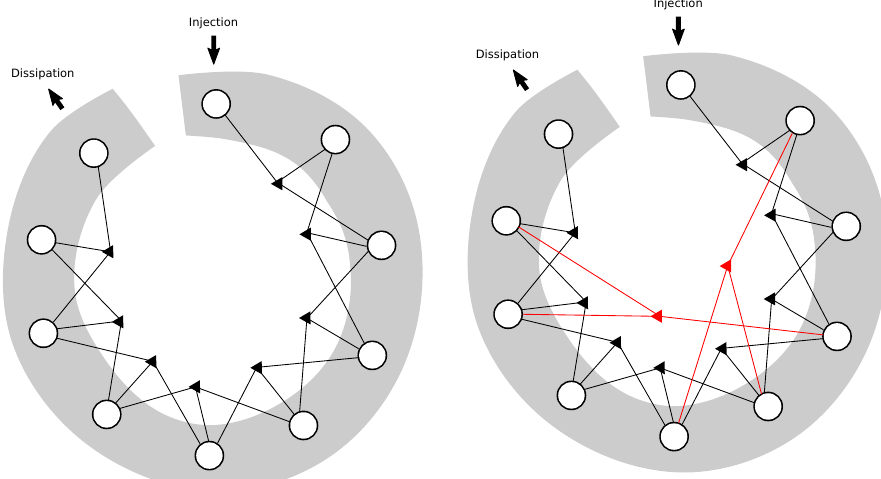
Figure 1. The standard GOY model on the left (10 nodes, shown as an unclosed ring), and the small world version on the right, with some randomly added triads. Note that each triad enters an additional link to the list of connections for each of its three nodes. Note that the triangles for these disparate scale interactions are very